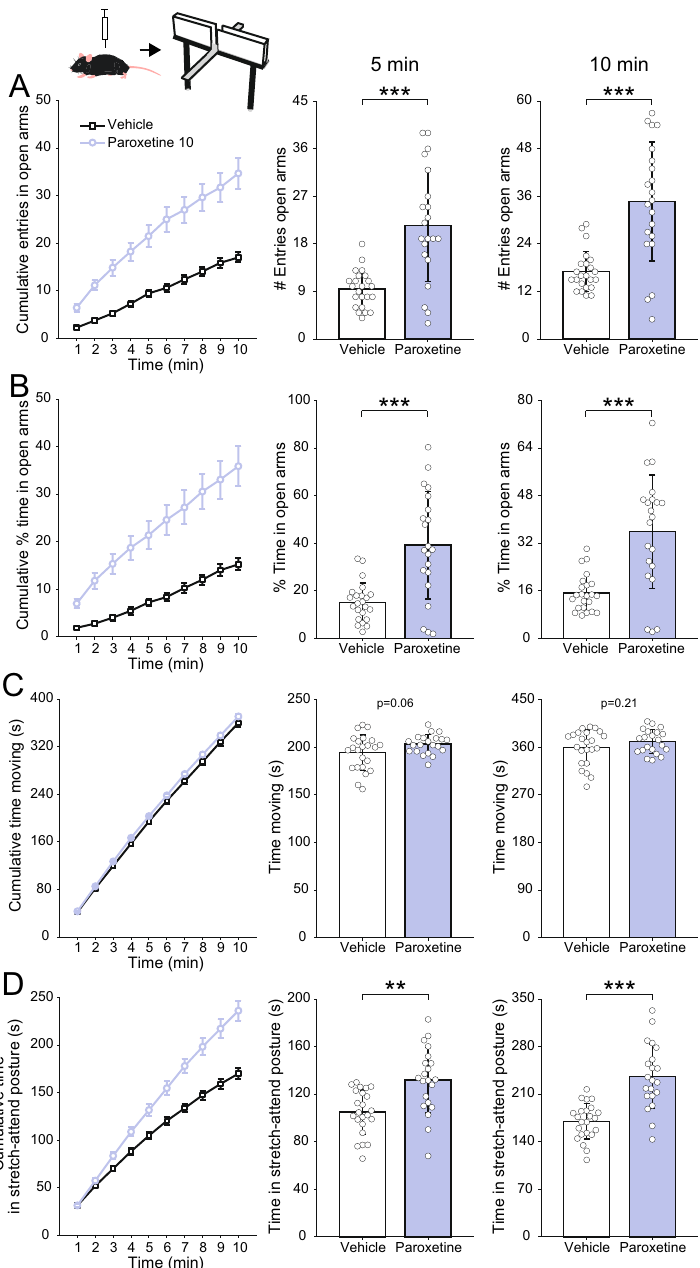
Figure 3. Anxiolytic effects of paroxetine in the elevated plus maze. ( A ) (Left) Cumulative number of entries in the open arms of the maze along the 10-min session. (Middle and right) Mean (± SD) number of open arm entries after 5 (middle) and 10 min (right). White circles show data for individual animals. Animals were treated with vehicle or paroxetine (10 mg/kg) 1 h prior to behavioral testing. ( B – D ) Panels show the same as in ( A ), but for the percentage of the time spent in the open arms ( B ), and the total time animals spent moving ( C ) or in stretch-attend posture ( D ). Paroxetine-treated animals exhibited a pronounced anxiolytic-like behavioral profile along with no change in locomotor activity and an increase in risk assessment behavior shown as increased time in stretch-attend posture. **p < 0.001, ***p < 0.0001, two-sample